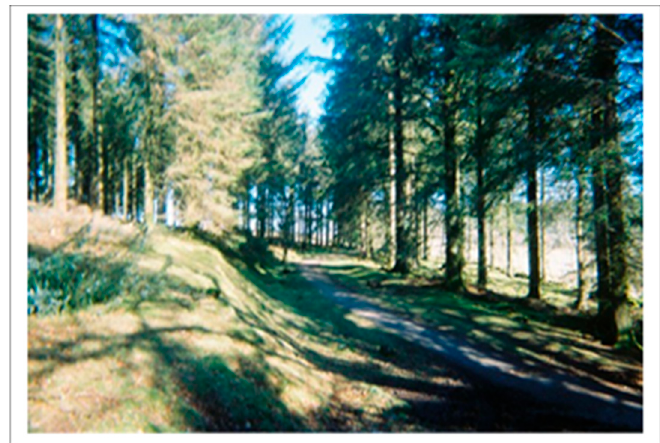
Figure 5. Photograph taken by Jen of her favourite peaceful place.